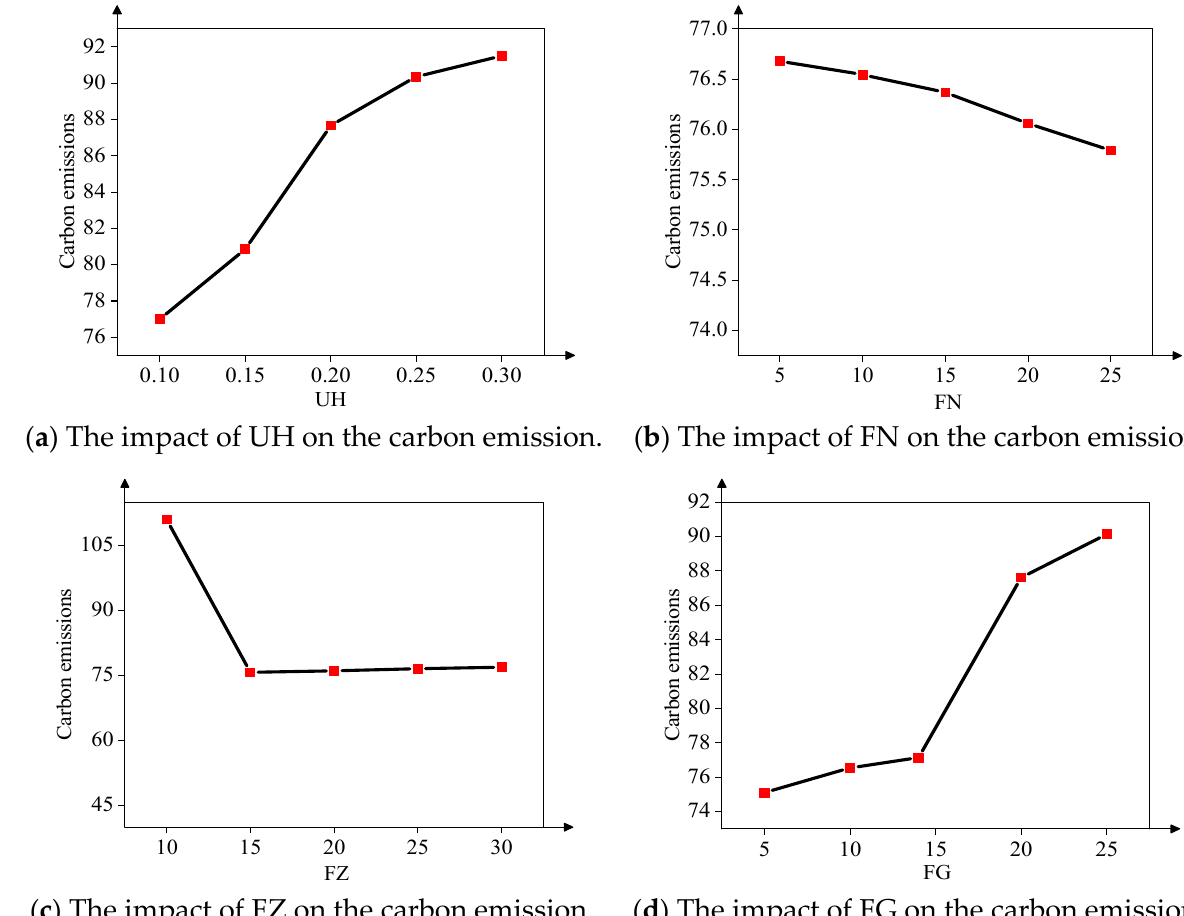
( d ) The impact of FG on the carbon emission. Figure 5. The impact of various parameters on the carbon emission. Figure 5. The impact of various parameters on the carbon